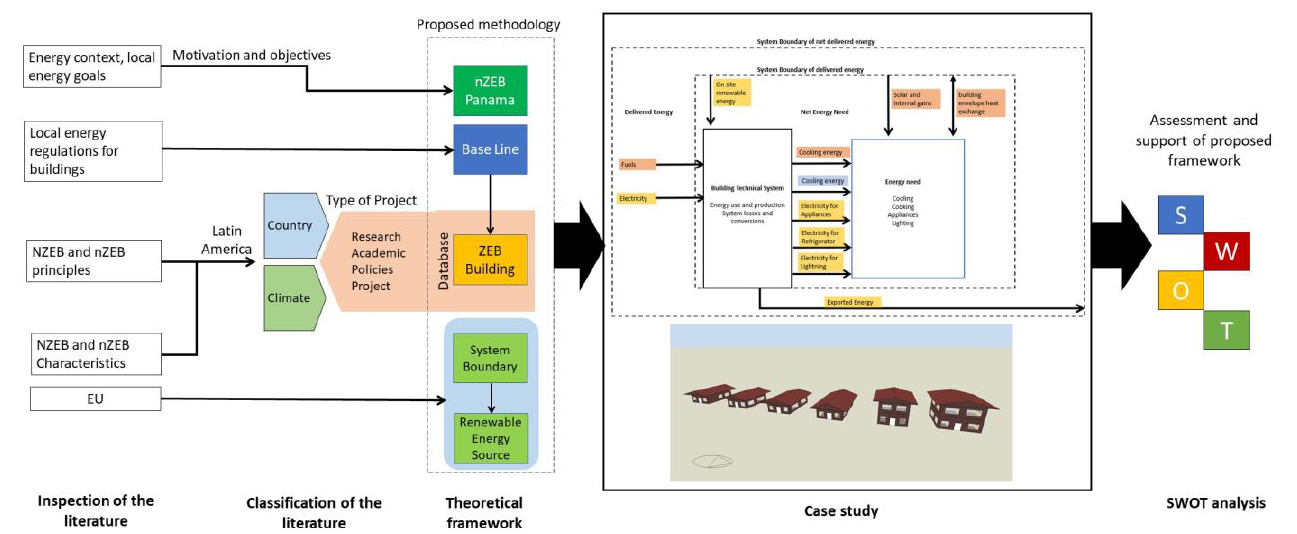
Figure 4. Research strategy flow followed in this study.